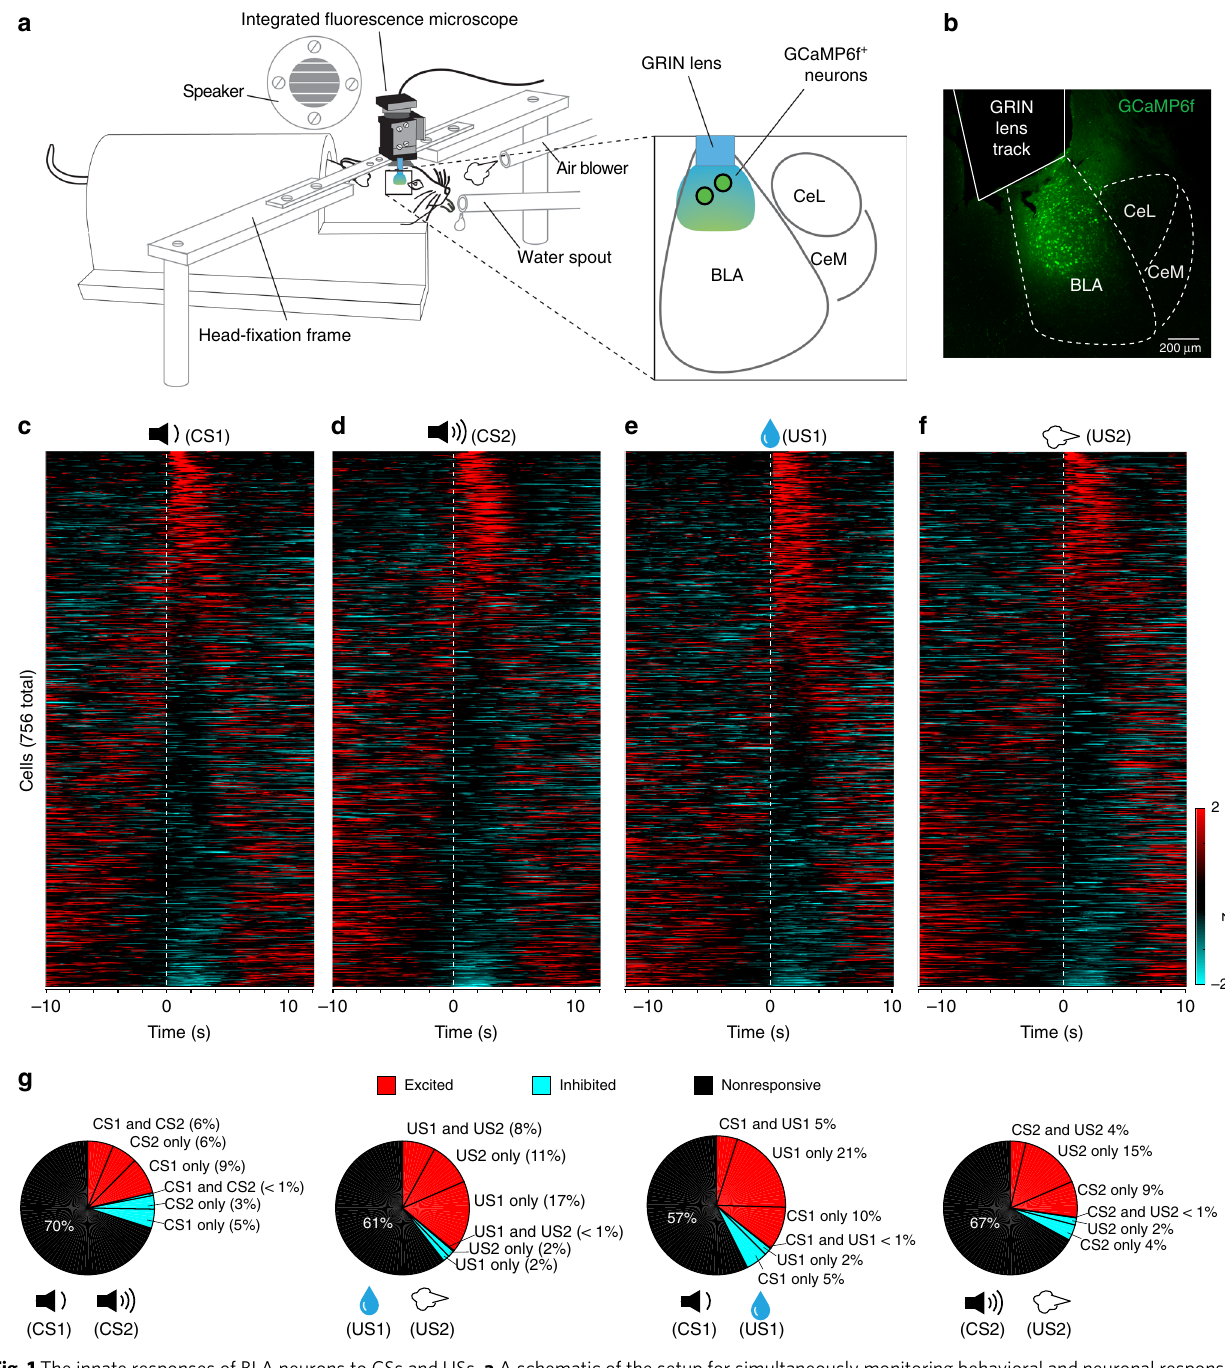
Fig. 1 The innate responses of BLA neurons to CSs and USs. a A schematic of the setup for simultaneously monitoring behavioral and neuronal responses in head-restrained mice. We imaged GCaMP6 signals in BLA neurons through GRIN lenses in behaving mice using a miniature integrated fl uorescence microscope mounted on the head. b A representative confocal image of a coronal brain section containing the BLA, in which the track of an implanted GRIN lens was on top of the BLA neurons expressing GCaMP6f. c Heatmaps of the activities ( z -scores) for all neurons ( n = 756 neurons, six mice) in trials in which CS1 was presented (indicated by the dashed line). Each row represents the temporal activities of one neuron. Neurons are sorted according to their average z -scores during the 1-s time window immediately after CS1 onset. d – f Same as ( c ), except that CS2 ( d ), US1 (water reward) ( e ), or US2 (air-puff) ( f ) was presented as the stimulus. g Pie charts showing the percent distributions of neurons responsive to different stimuli before learning. Note that at this stage, inhibitory responses were rare; and only a small percentage of neurons responded to both CS1 and US1, or to both CS2 and